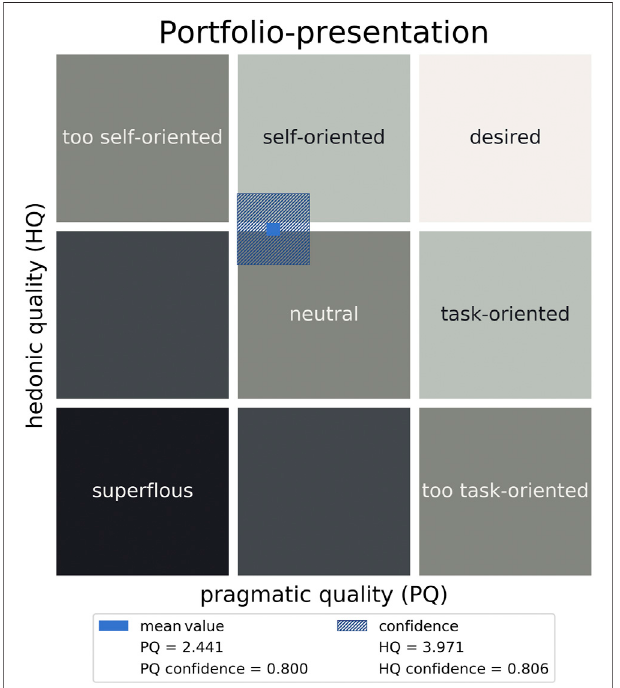
FIGURE 10 | Portfolio-presentation of the AttrakDiff values. The small dark blue square represents the classi fi cation of the VR Forge prototype, and the light blue square represents the con fi dence.